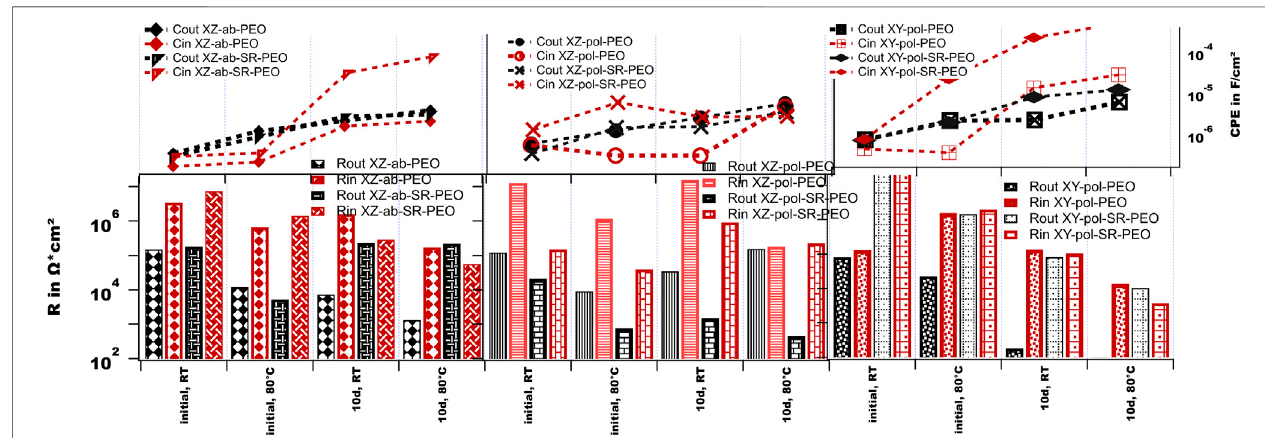
FIGURE 13 | Simulated values for the EIS measurements of the PEO-treated surfaces.